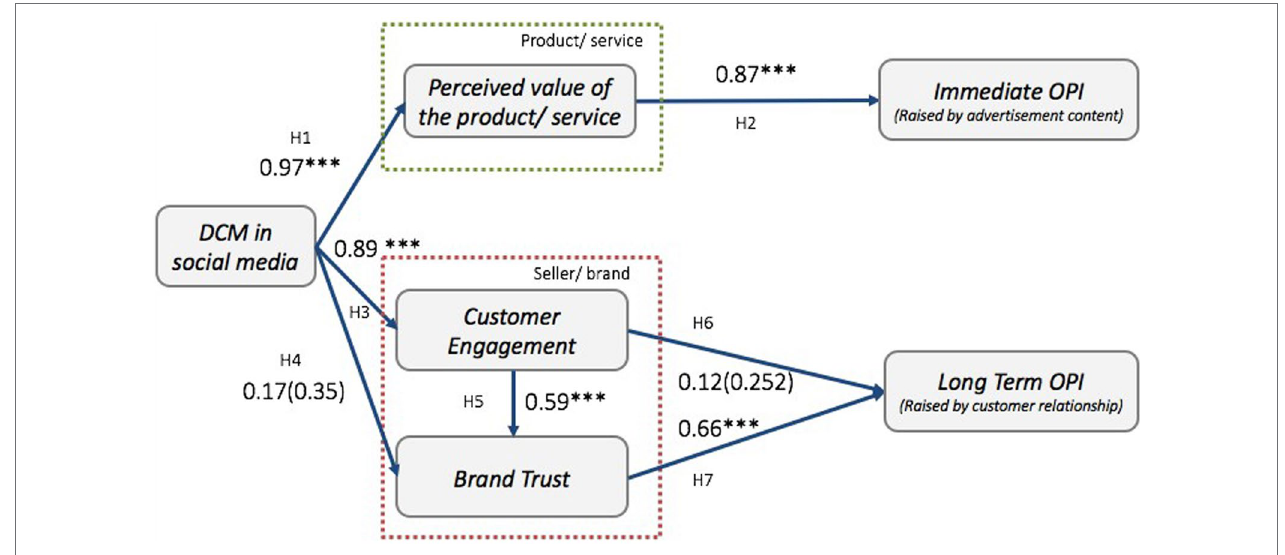
FIGURE 3 | Structural Equation Model (SEM) result. ***< 0.01.